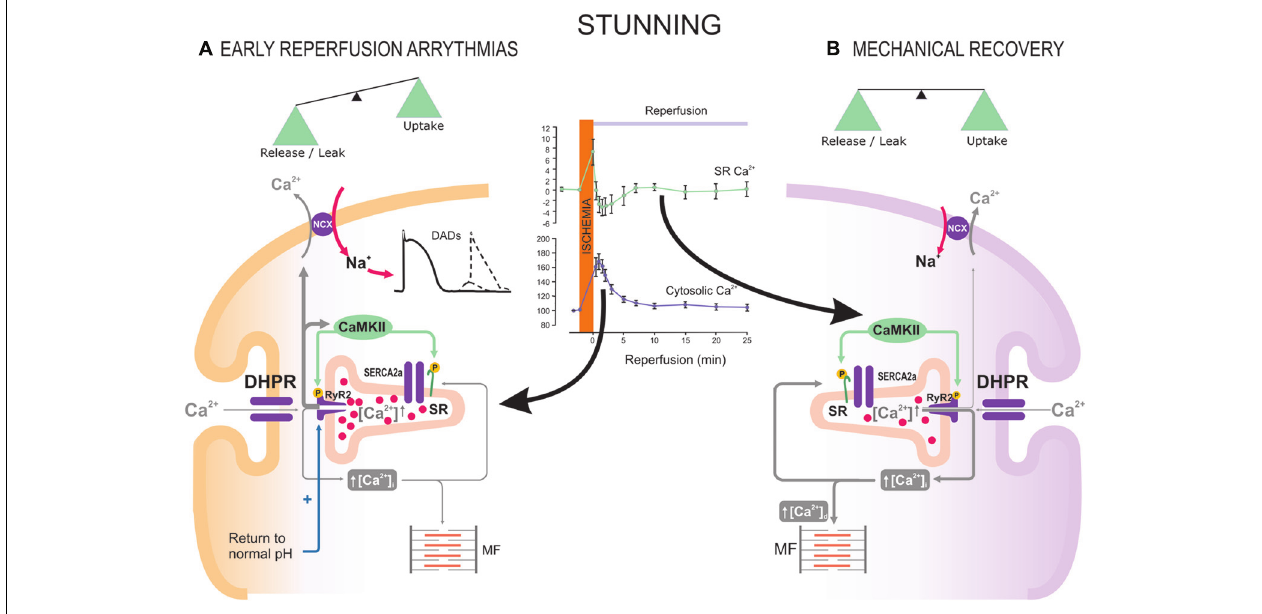
FIGURE 4 |The beneficial or detrimental effects of CaMKII activation and PLN phosphorylation in I/R depend on a tight balance between SR Ca 2+ reuptake and leak. Reperfusion after a short ischemic period (stunning) is associated with an increase in CaMKII-dependent PLN and RyR2 phosphorylation. During early reperfusion (A) , there is: abrupt release of SR Ca 2 + (inset of the Figure,Valverde etal., 2010), possibly favored by the ischemia-induced increase in SR Ca 2 + content; relief of RyR2 inhibition